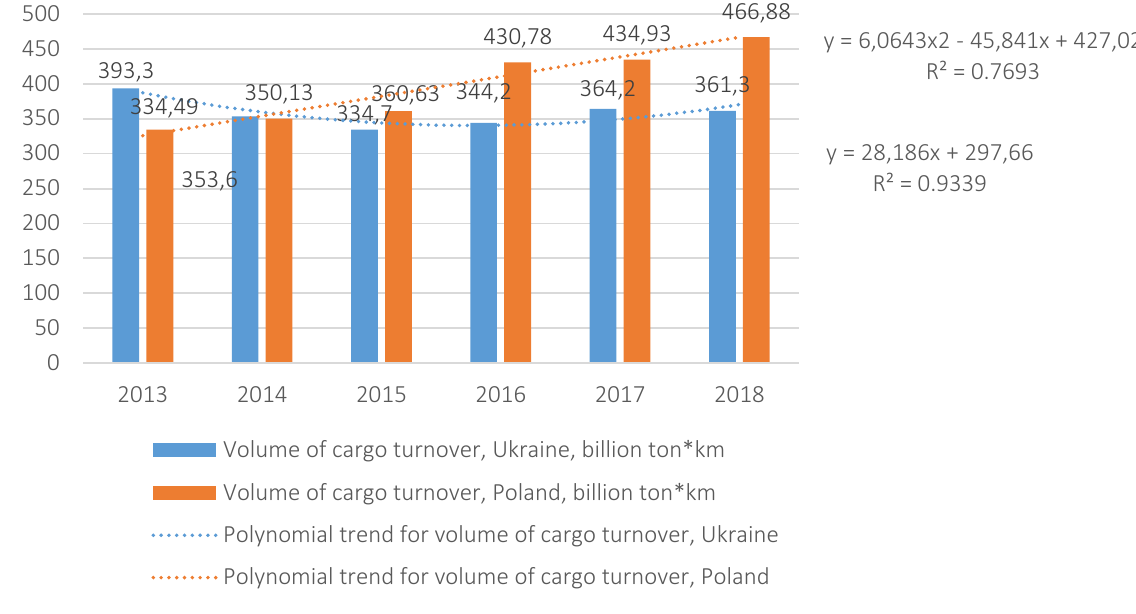
Figure 6. The dynamics of volume of cargo turnover in 2013–2018 in Ukraine and Poland, billion